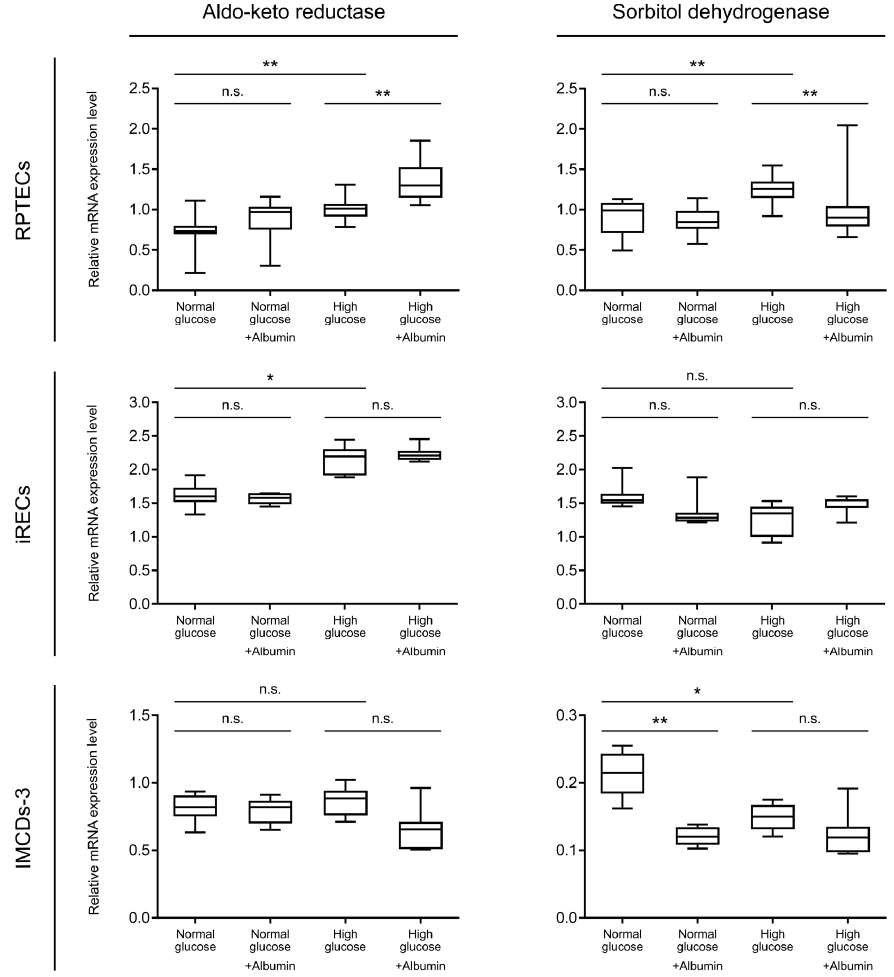
Figure 4. Relative mRNA expression level of aldo-keto reductase and sorbitol dehydrogenase as detected by qPCR analysis. Comparison between normal and high glucose; normal glucose with/without albumin overload, and high glucose with/without albumin overload. Data are shown for RPTECs (upper line), iRECs (intermediate line), and IMCD-3 cells (lower line). Boxplots display the mean values of three replicates with 95% confidence intervals (whiskers). p -values: n.s. not significant, * p < 0.05, ** p < 0.01. Although the inhibition of aldo-keto reductase seems to be beneficial in diabetes [41], little is